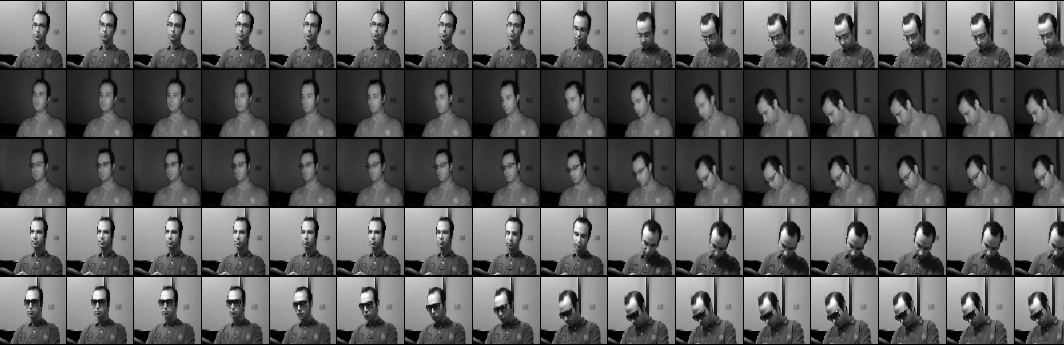
Figure 7. Various sequences of a subject with different postures from the NTHU-DDD